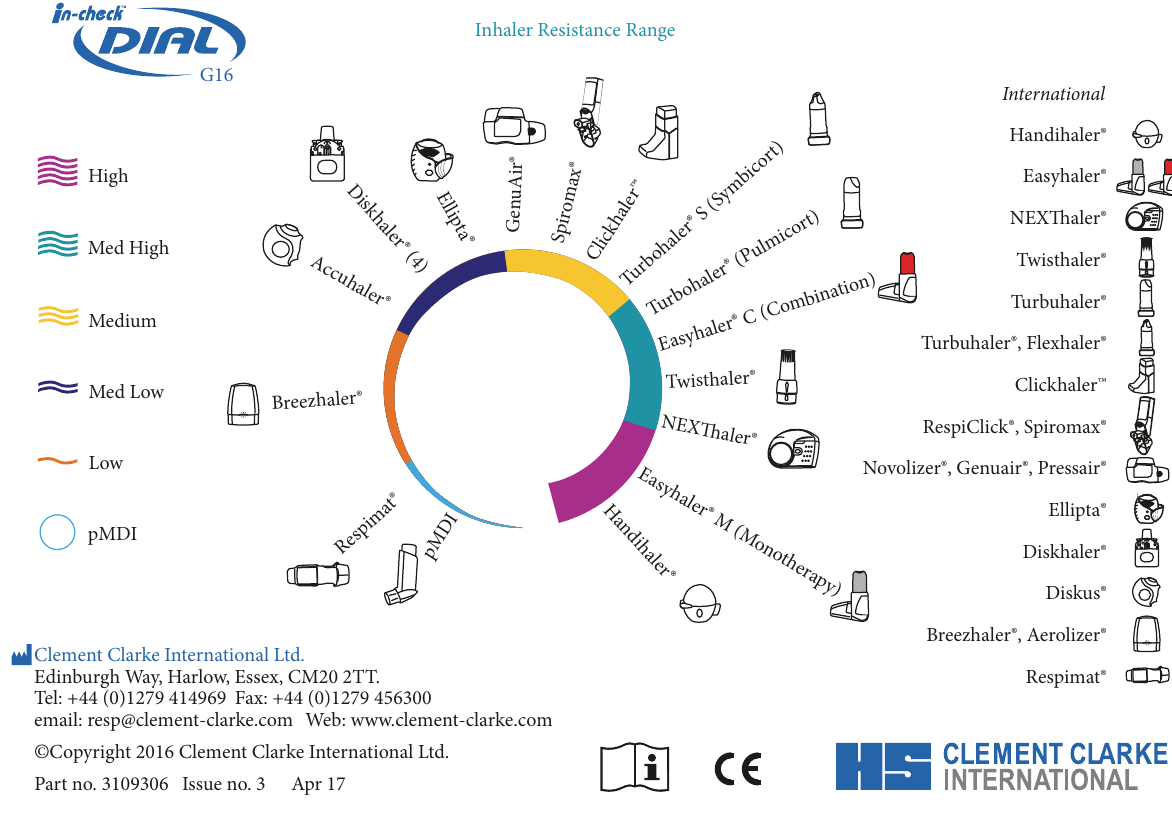
Figure 2: In-Check DIAL G16 Information